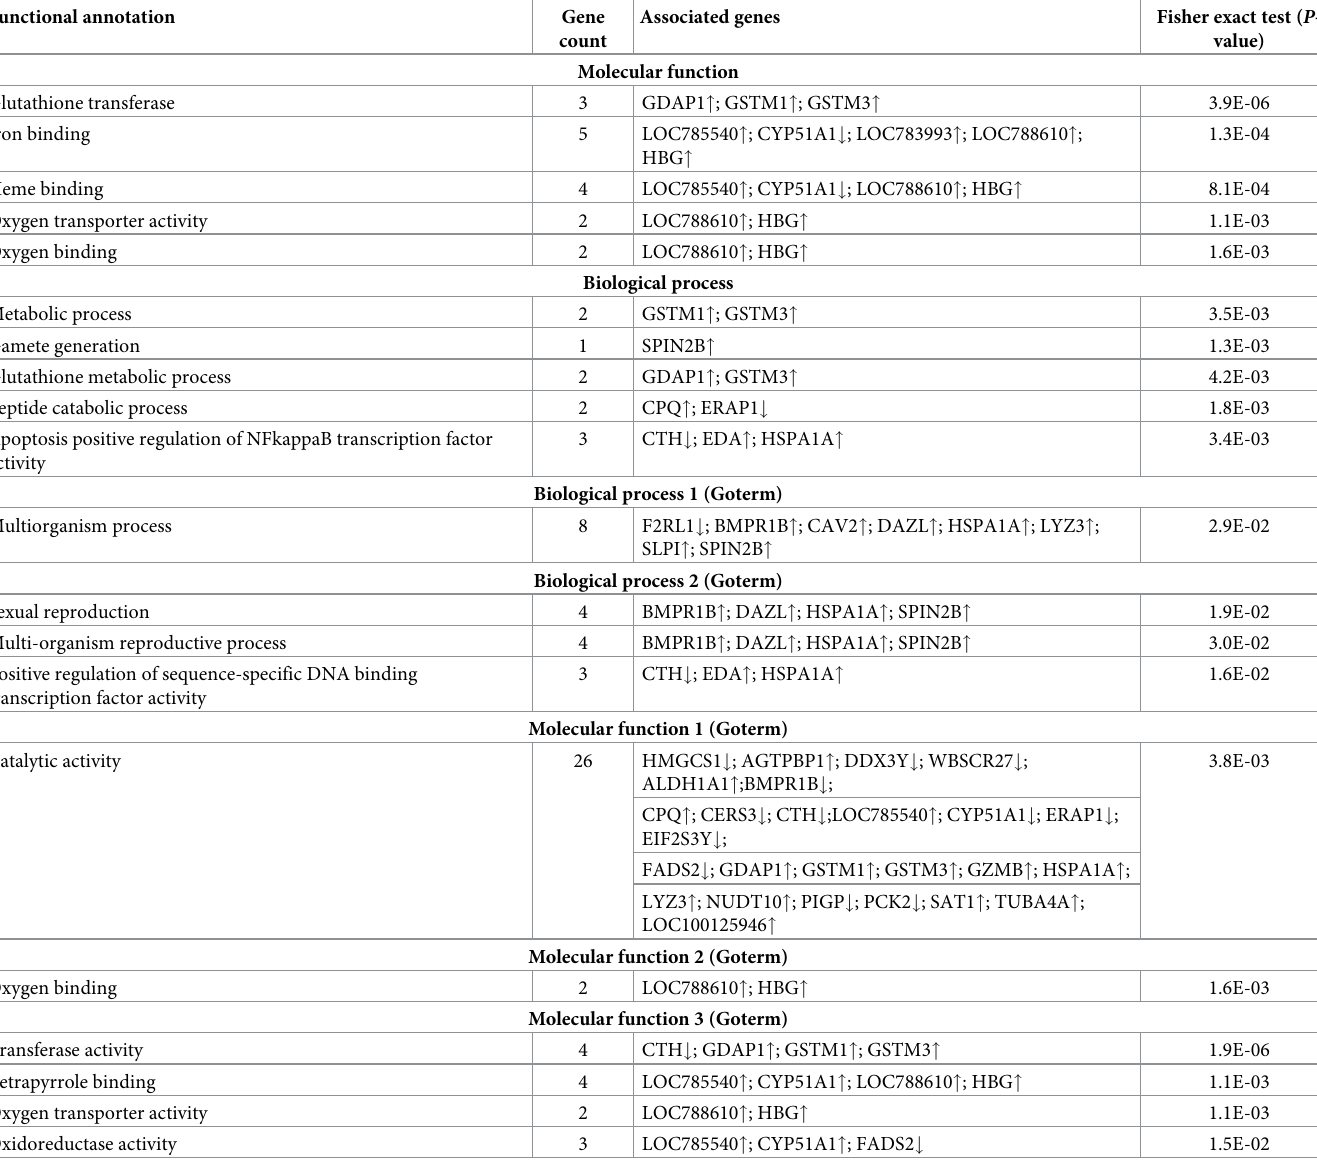
Table 3. Enrichment analysis of differentially expressed genes in blastocysts that developed from synchronously vs. asynchronously cleaved embryos (DAVID). Functional